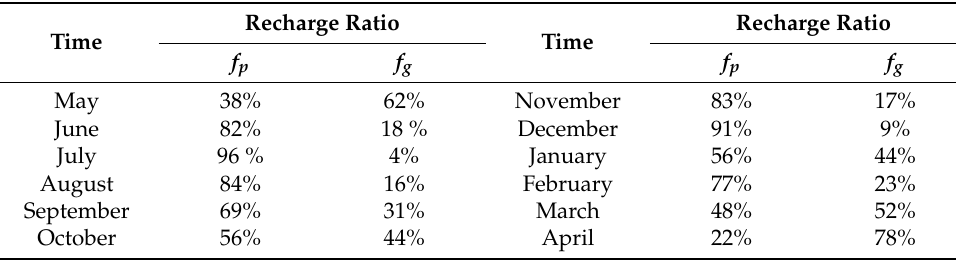
Figure 6. Relationship between the precipitation, groundwater, and terrace water across seasons. Table 2. Statistics of the precipitation and groundwater ratios in the study area: f p is the proportional contribution of the precipitation; f g is the proportional contribution of the groundwater.